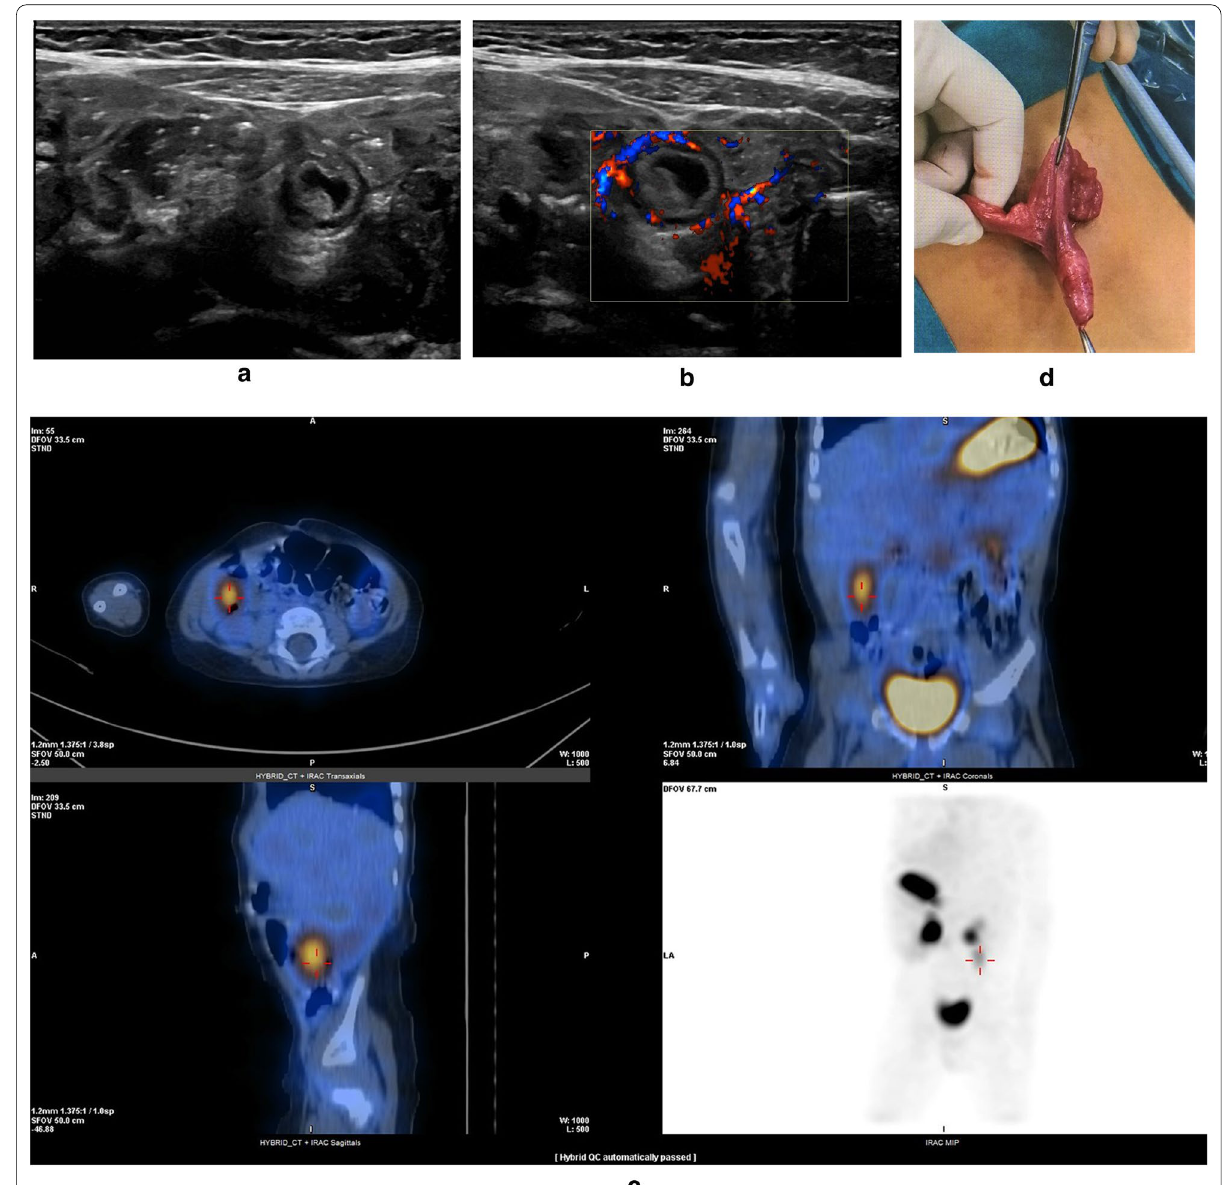
Fig. 6 A 10‑month‑old boy with frank bleeding per rectum. a , b Ultrasound showed pseudogestational sac sign with peripheral vascularity on colour Doppler highly suggestive of Meckel’s diverticulum. c SPECT CT done 3 days later was positive for Meckel’s showing a focal area of increased technetium uptake at the right lumbar region corresponding to the ultrasound abnormality. d Intraoperative photograph showing the diverticulum. Histopathology revealed Meckel’s diverticulum showing heterotopic gastric mucosa with degenerative changes and chronic inflammation